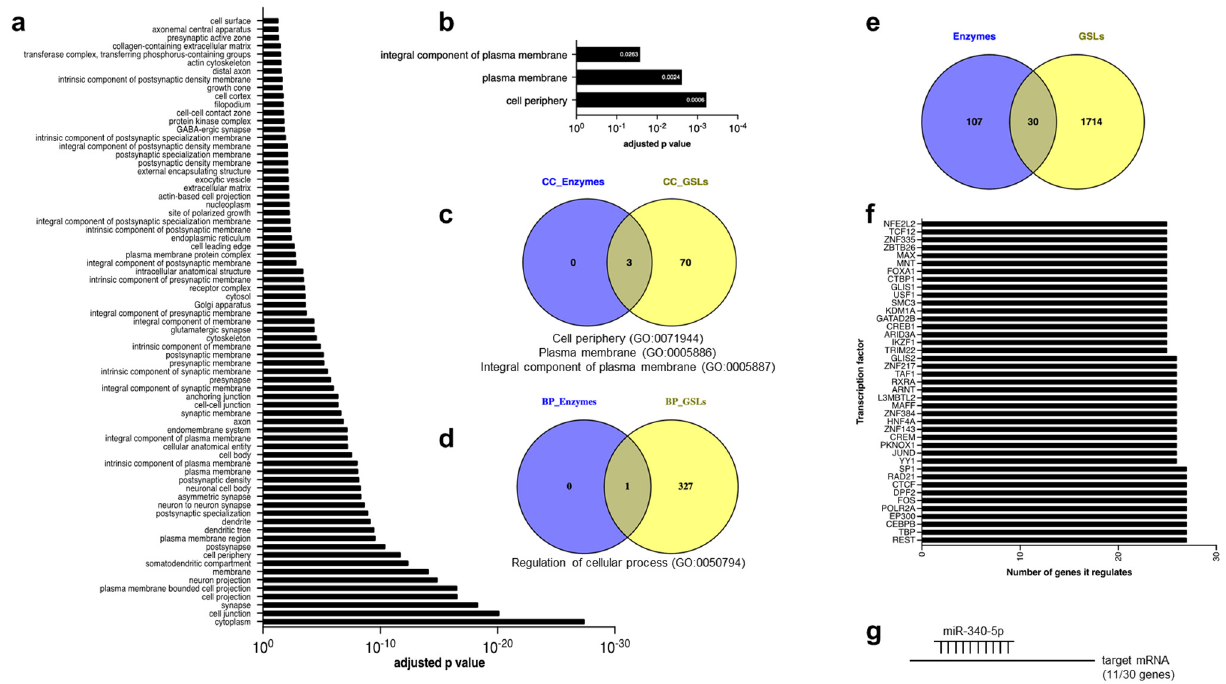
Figure 7. Enrichment analysis and common modifier genes between glycosphingolipids levels and lysosomal enzyme activities. ( a ) Cellular component functional enrichment analysis for gene sets (1744 non − redundant genes) of six substrate (GM3 − Gc, GA2, Lac, GM1b, GD1b, GD1a), analyzed by g:Profiler. We found 73 GO_CC associated. ( b ) Cellular component functional enrichment analysis for gene sets (137 non − redundant genes) of eight enzymes (acid β − glucosidase, α − galactosidase A, α − galactosidase B, α − glucosidase, β − D − galactosidase, chitotriosidase, α − L − fucosidase, tartrate − resistant acid phosphatase). ( c ) Venn diagram with common GO terms cellular component between two traits. ( d ) Common GO terms biological processes between two traits. ( e ) Common genetic regulators between two traits. ( f ) Transcription factors that bind to the common genes. ( g ) Cartoon with common genetic regulators that miR − 340 − 5p can bind.